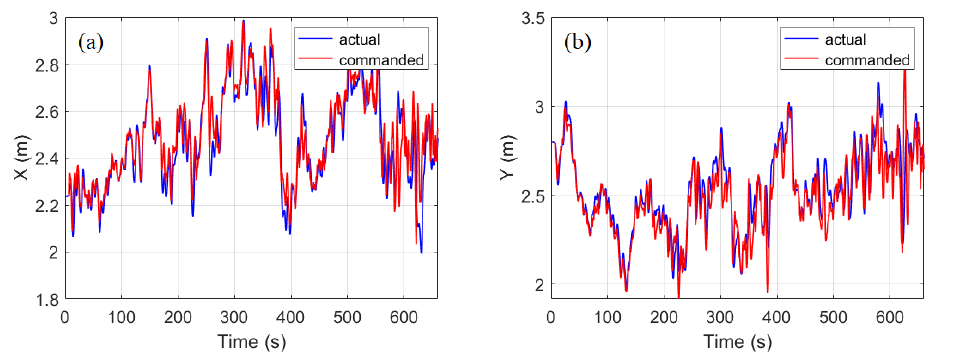
Figure 14. Results of reference trajectory tracking. ( a ) Time history of X. ( b ) Time history of